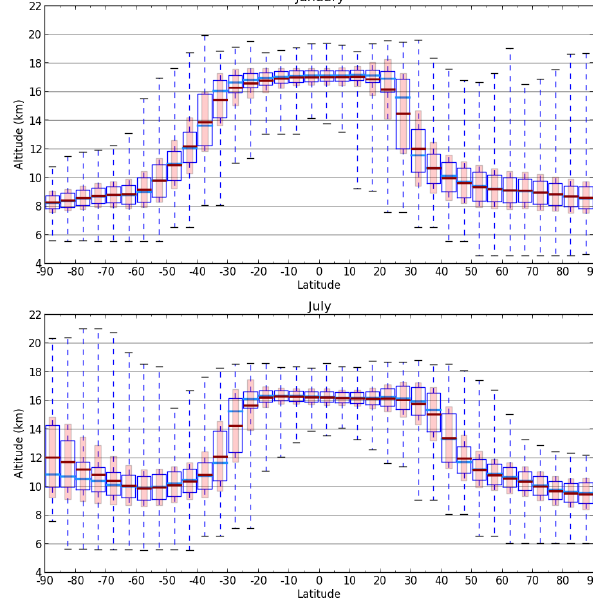
Figure 3. Altitudes of the first tropopause versus latitude for Jan- uary (top) and July (bottom) from 2001 to 2013. Shown are the mean (dark red line), one standard deviation (bright red bars), median (blue bar), 25 to 75 quartile (box), and extreme values (whiskers) for 5 ◦ latitudinal